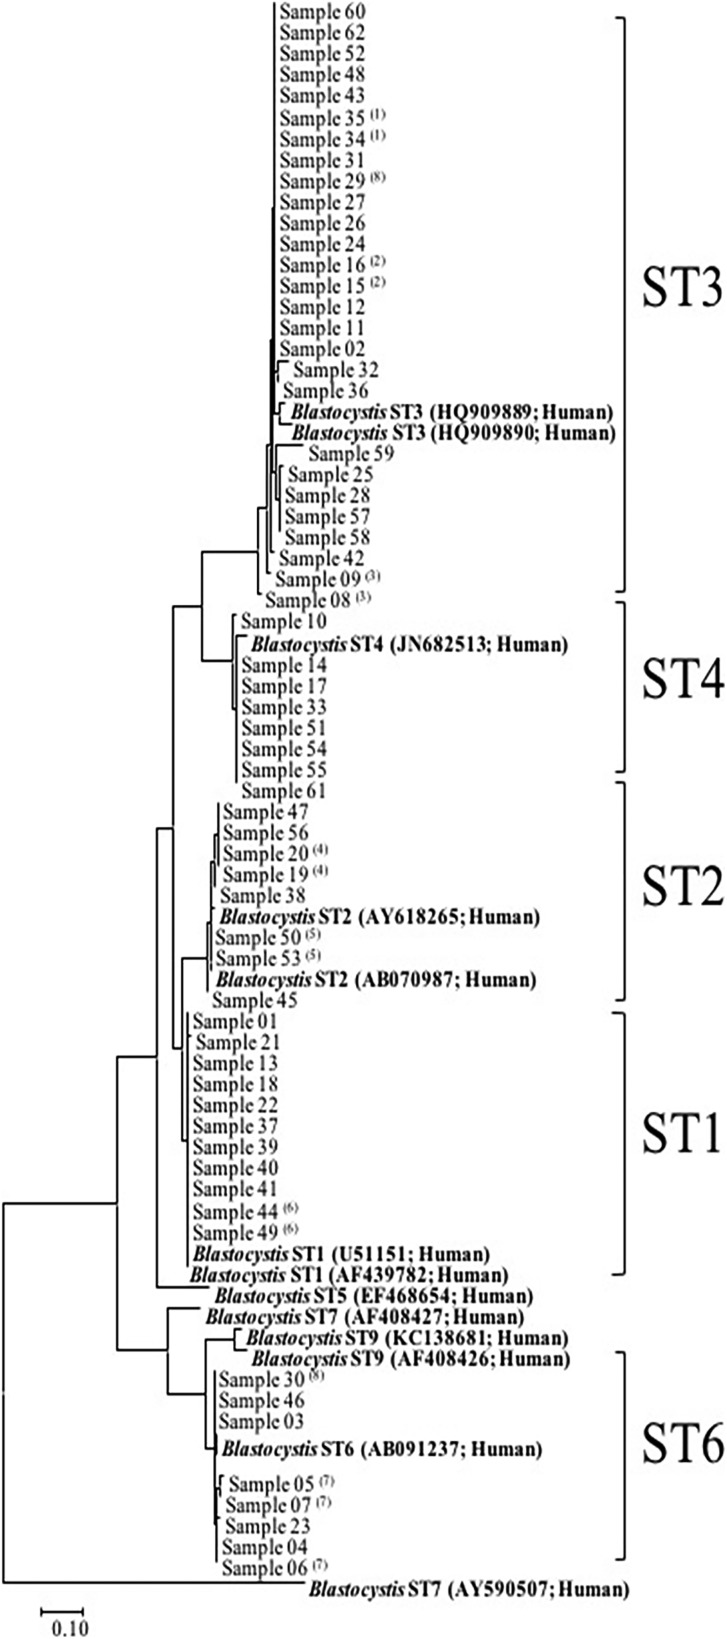
Phylogenetic relationship between the SSD rDNA sequence of Blastocystis. The molecular phylogenetic analysis was carried out using the Maximum Likelihood method based on the Tamura–Nei model. ST, subtype; (n): patient number in case of multiple samples.